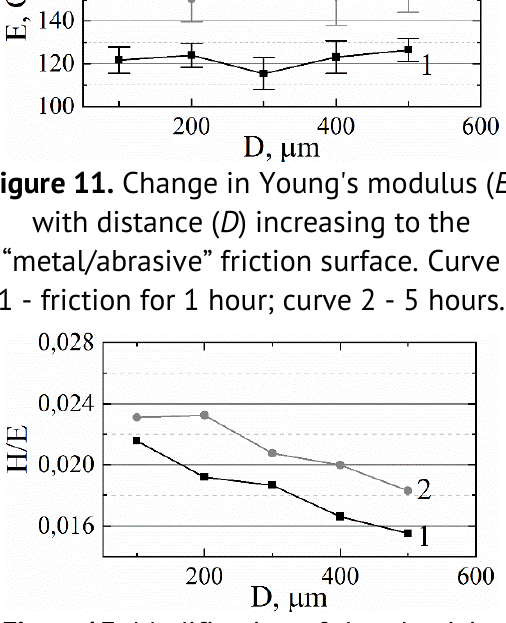
Figure 12. Modification of the plasticity index, H/E , as it moves away from the friction surface “metal/metal”. Curve 1 - friction for 1 hour; curve 2 - 10 hours.